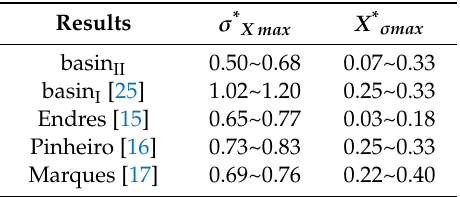
Table 4. Coefficients of a , b, c , d , and the statistical performance criteria to estimate ϭ *X .